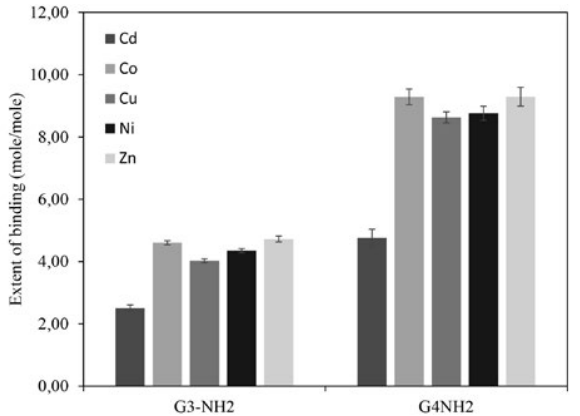
Figure 5. EOB and selectivity properties of different generation JCPDs towards heavy metals Cd(II), Co(II), Cu(II), Ni(II), and Zn(II) at pH 9.